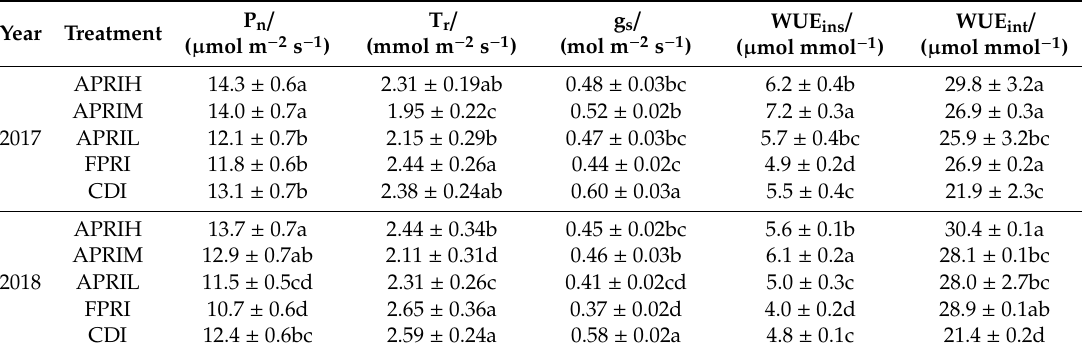
Table 3. Physiological parameters of the processing tomato under di ff erent irrigation